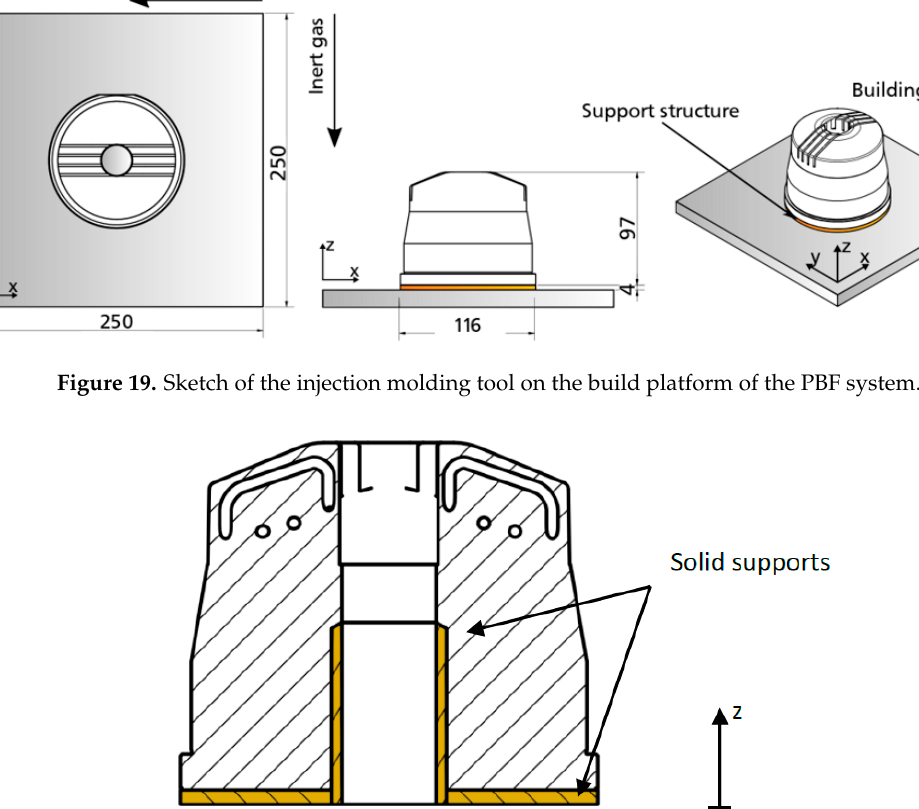
Figure 20. Support Structures.